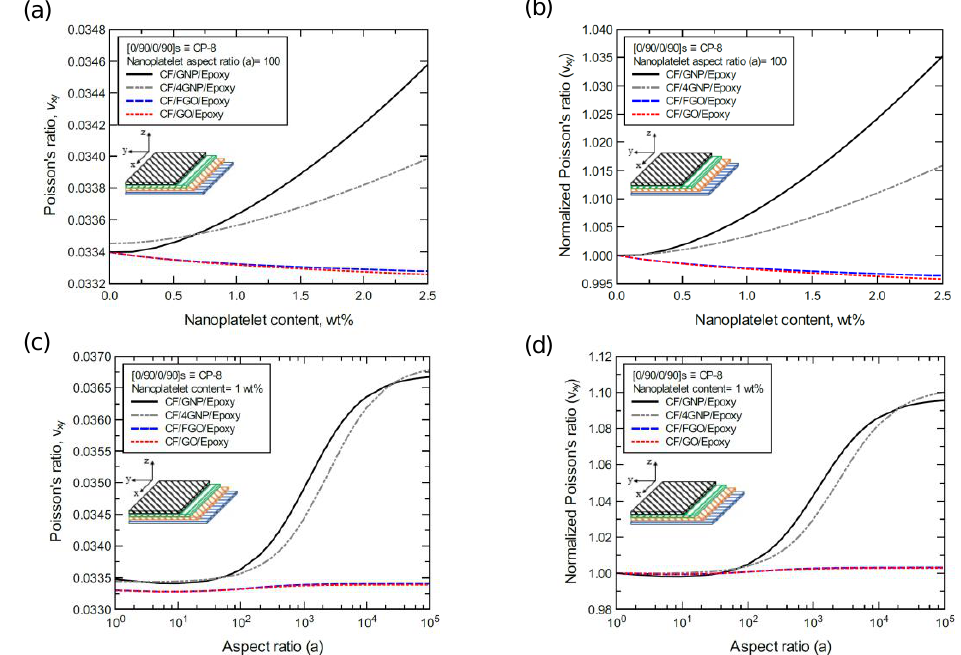
Figure 24. Comparison of the predicted in- plane Poisson’s ratio (ν xy ) for a [0/90/0/90]s (CP-8)-laminated composite plate based on the nanoplatelet type, content, and aspect ratio; ( a ) predicted ν xy for various nanoplatelet contents at 100 aspect ratio, and the normalized response is shown in ( b ); ( c ) predicted ν xy for various aspect ratio values at 1.0 wt% nanoplatelet content, and the normalized response is shown in ( d ). The volume fraction of CF is 56%.